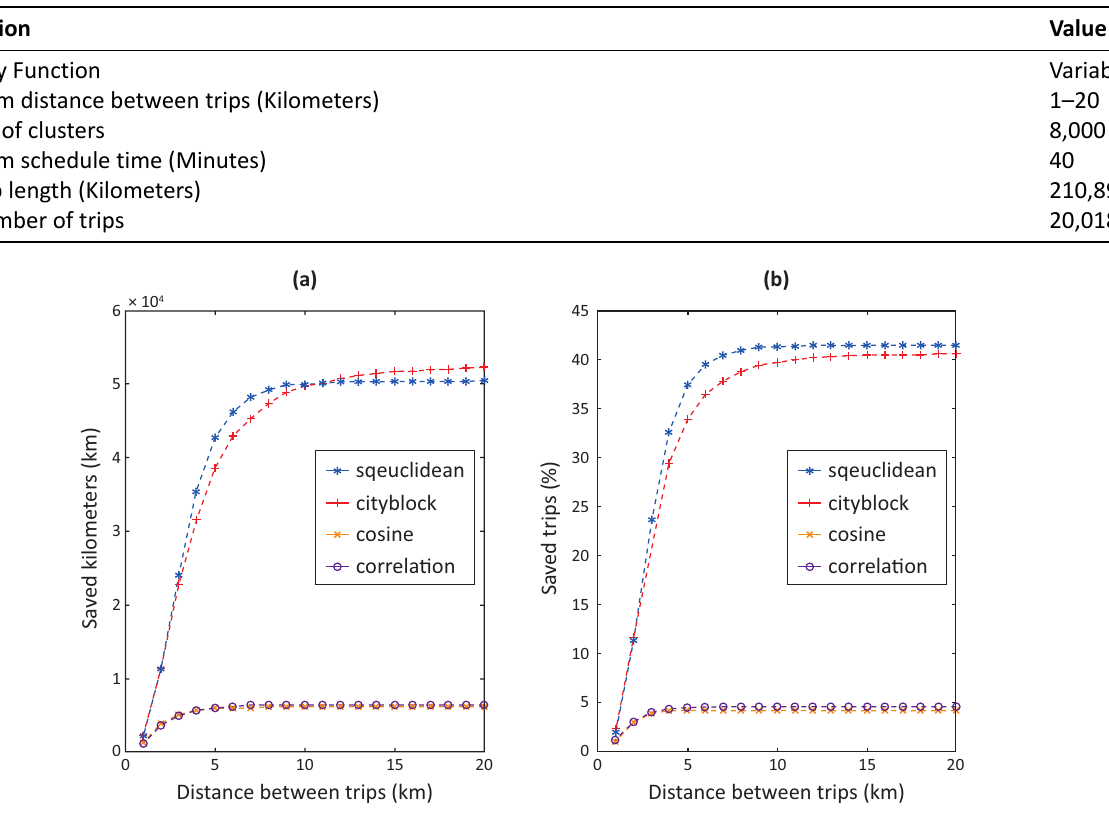
Figure 5. Effect of similarity function and distance between trips on (a) saved kilometers (b) number of saved